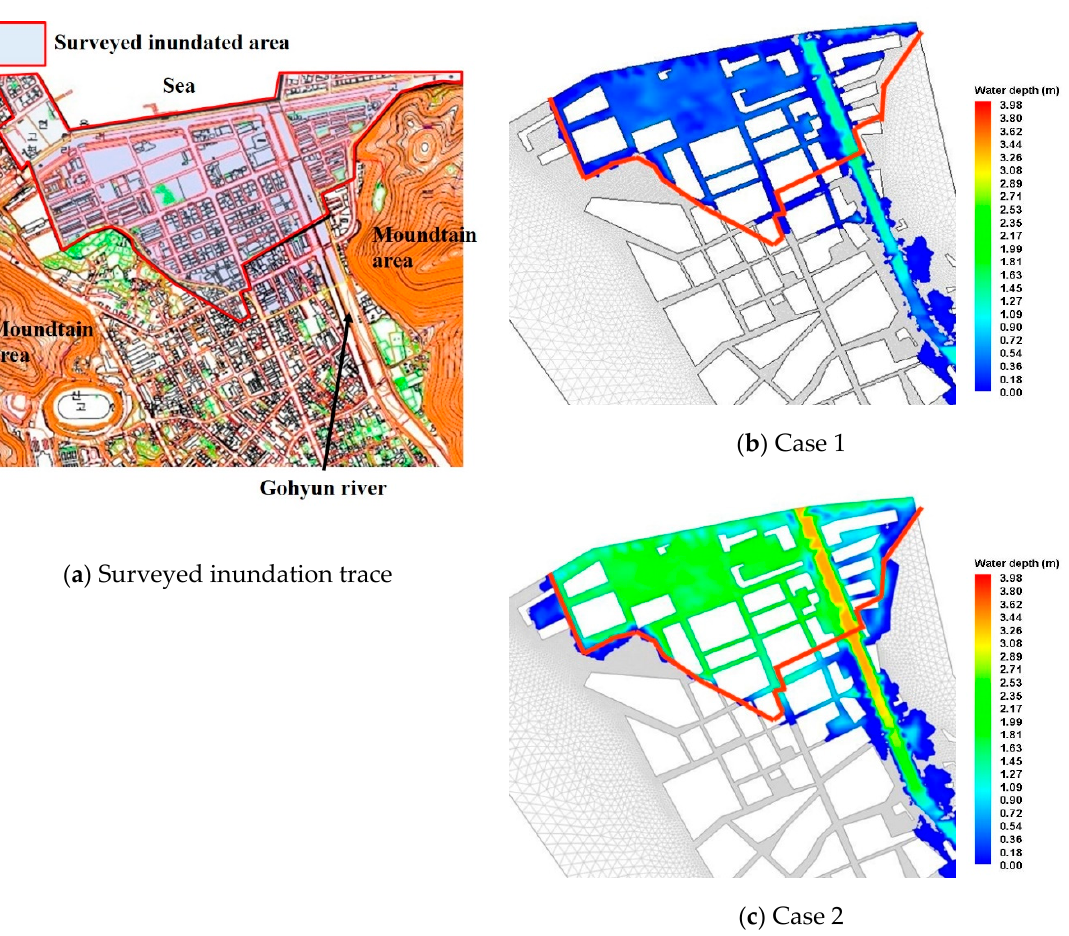
Figure 9. Comparison between the surveyed inundation trace and the simulated inundation distribution for Case 1 and 2 (Red line represents the boundary of flooded area).